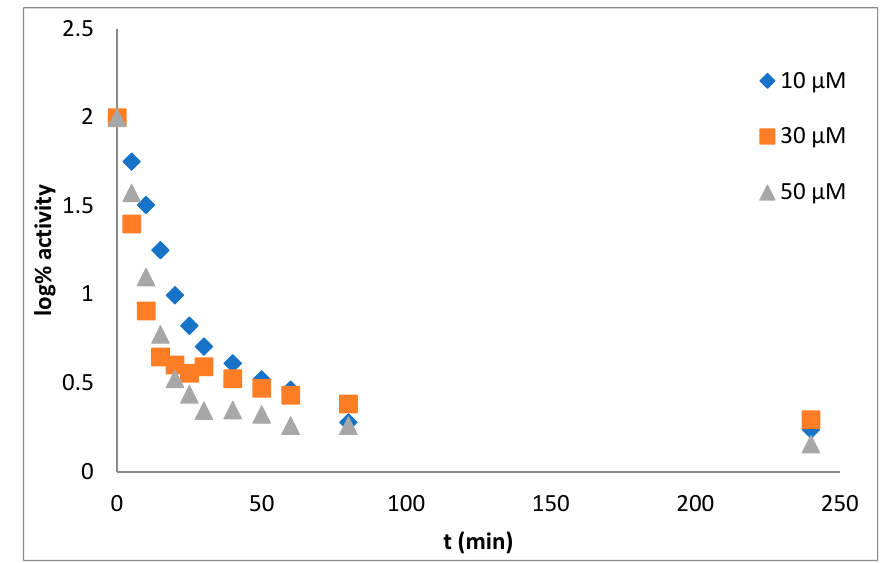
Figure 1. The dependence log% A vs. time. Enzyme: acetylcholinesterase, derivative 5c , concentration of inhibitor: 10 µM (rhomb), 30 µM (square), 90 µM (triangle).